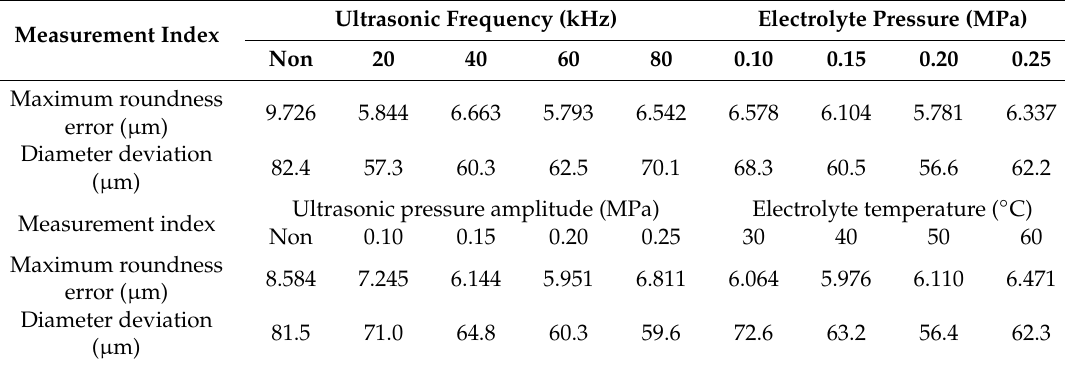
Table 2. The values of all parameters adopted for Figure 10.